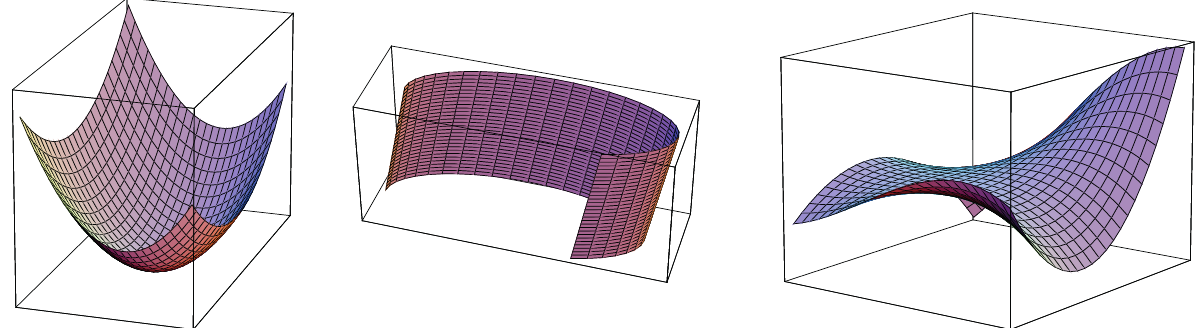
Figure 14. Caps, sheets and saddles with positive, zero, and negative Gaussian curvature.